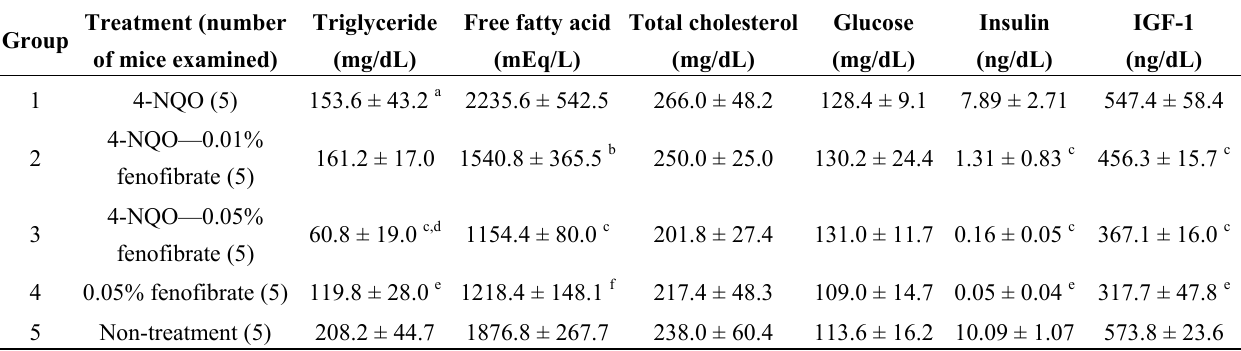
Table 2. Serum levels of triglyceride, free fatty acid, total cholesterol, glucose and insulin of mice at week